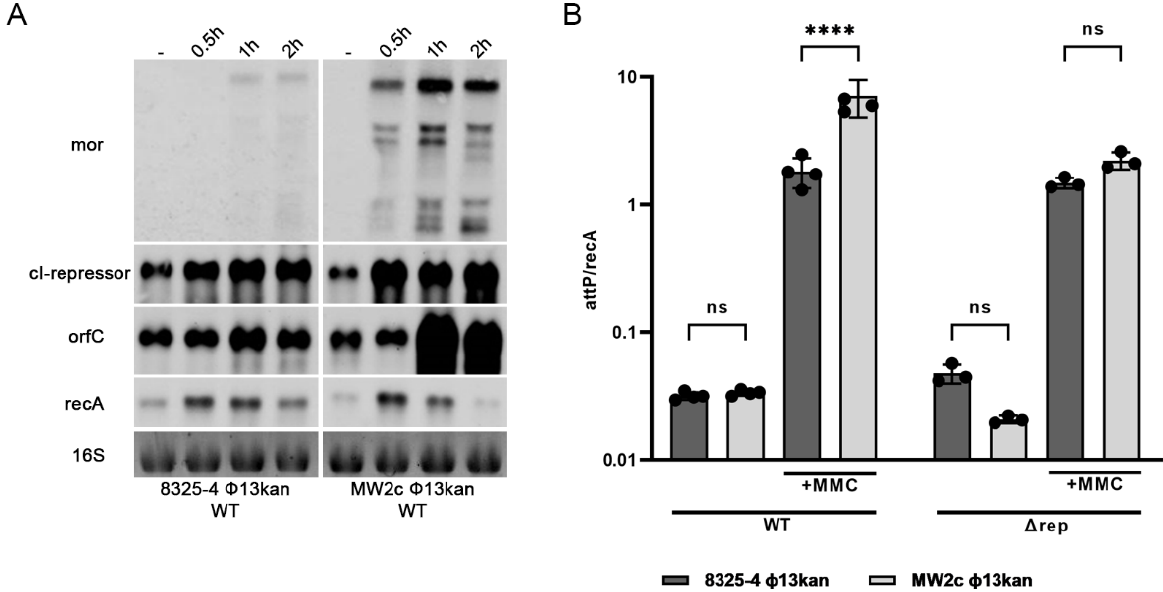
Figure 3. Phage replication is strain-dependent. Transcriptional analysis of phage-related genes (cI, mor, orfC) and chromosomally encoded recA under non-inducing and phage-inducing conditions ( A ). 8325-4 Ф 13kan and MW2c Ф 13kan were grown to OD 600 = 0.7 and treated with mitomycin for 0.5 h, 1 h, or 2 h) or without mitomycin (1 h). RNA was hybridized with digoxygenin labeled DNA probes. Phage induction/replication in wild type (8325-4 Ф 13kan, MW2c Ф 13kan) and replication- deficient derivatives ( Δ rep) under non-inducing and phage-inducing (1 h mitomycin, MMC) condi- tions ( B ). Phage excision/replication was enumerated as the ratio of excised, circularized phage cop- ies (attP) per copy of bacterial chromosome (recA) as quantified by qPCR. **** p ≤ 0.0001.